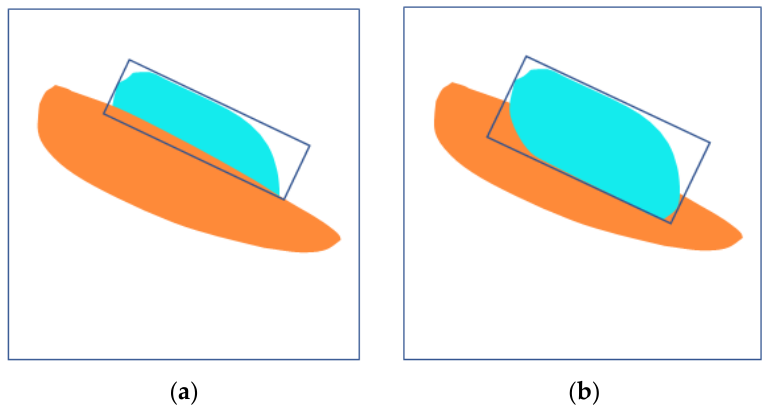
Figure 3. Change of detection frame in the case of target occlusion and non-occlusion. ( a ) indicates the blue object is occluded and ( b ) indicates the blue object is not occluded.